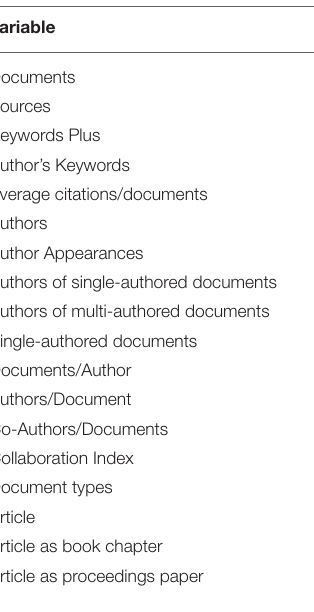
TABLE 1 | Main information on MPP-AD related research from 1982 to 2019.